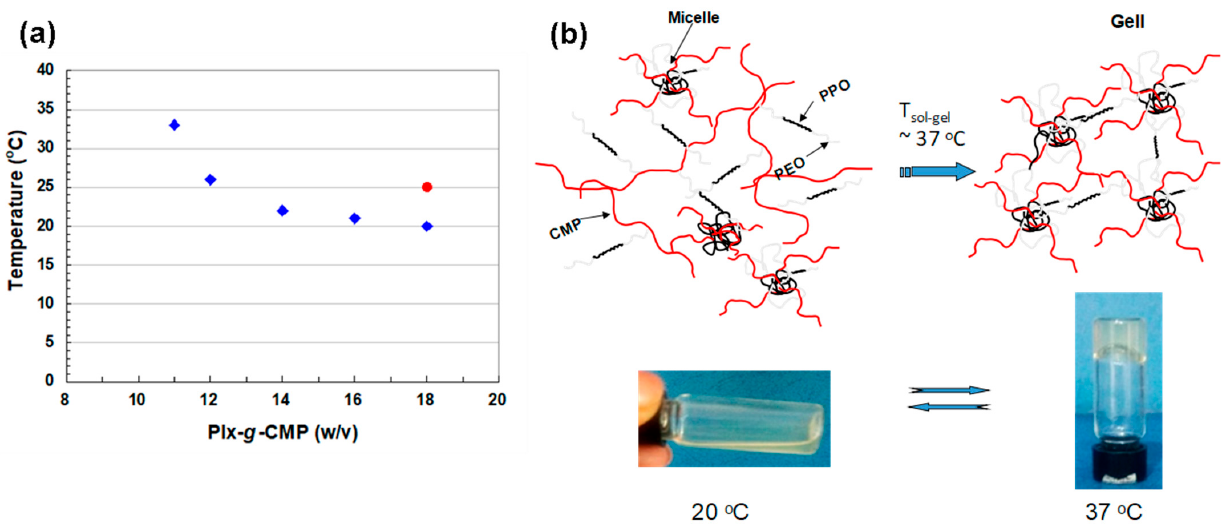
Figure 4. Influence of the polymer concentration on the gelation temperature of Plx ( • ) and Plx- g -CMP ( ◆ ) in phosphate buffer 0.05 M at pH = 7.4 ( a ). Schematic representation of sol–gel transition of the Plx- g -CMP solution ( b ).